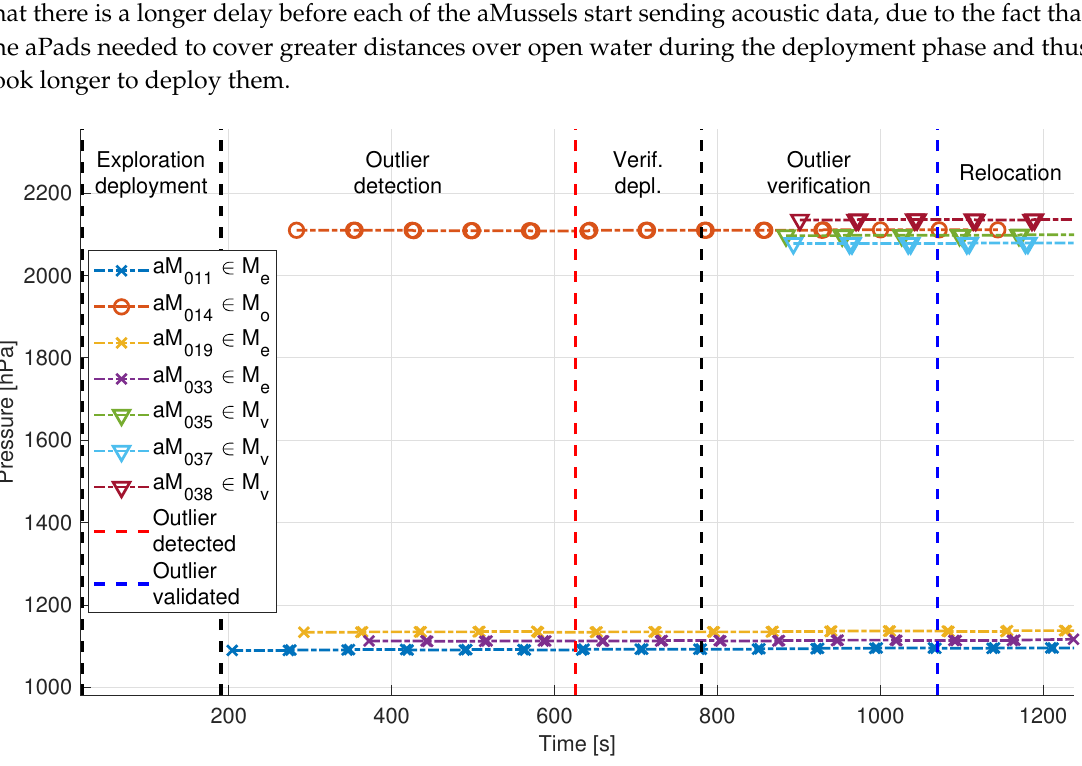
Figure 21. Pressure data exchanged via acoustic communication during the Venice experiment. aMussel 14 is the outlier and was successfully verified as